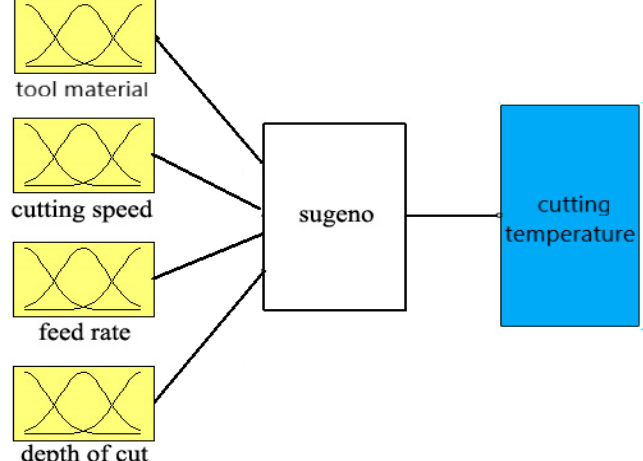
Figure 2. Four inputs and one output fuzzy inference system for cutting temperature.